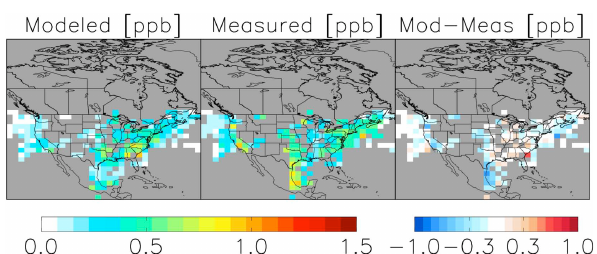
Fig. 9. Acetaldehyde in the boundary layer ( P> 800hPa) over North America. Simulated concentrations are compared to mea- surements from an ensemble of aircraft campaigns, with the obser- vations mapped on the 2 ◦ × 2.5 ◦ model grid and the model sampled at the same time and day of year as the measurements. The eastern North America data (INTEX-A, ITCT-2K4) are for July–August, and the western data (ITCT-2K2, INTEX-B) are for April–May. Data over the Gulf Coast and Mexico are for March (MILAGRO) and September-October